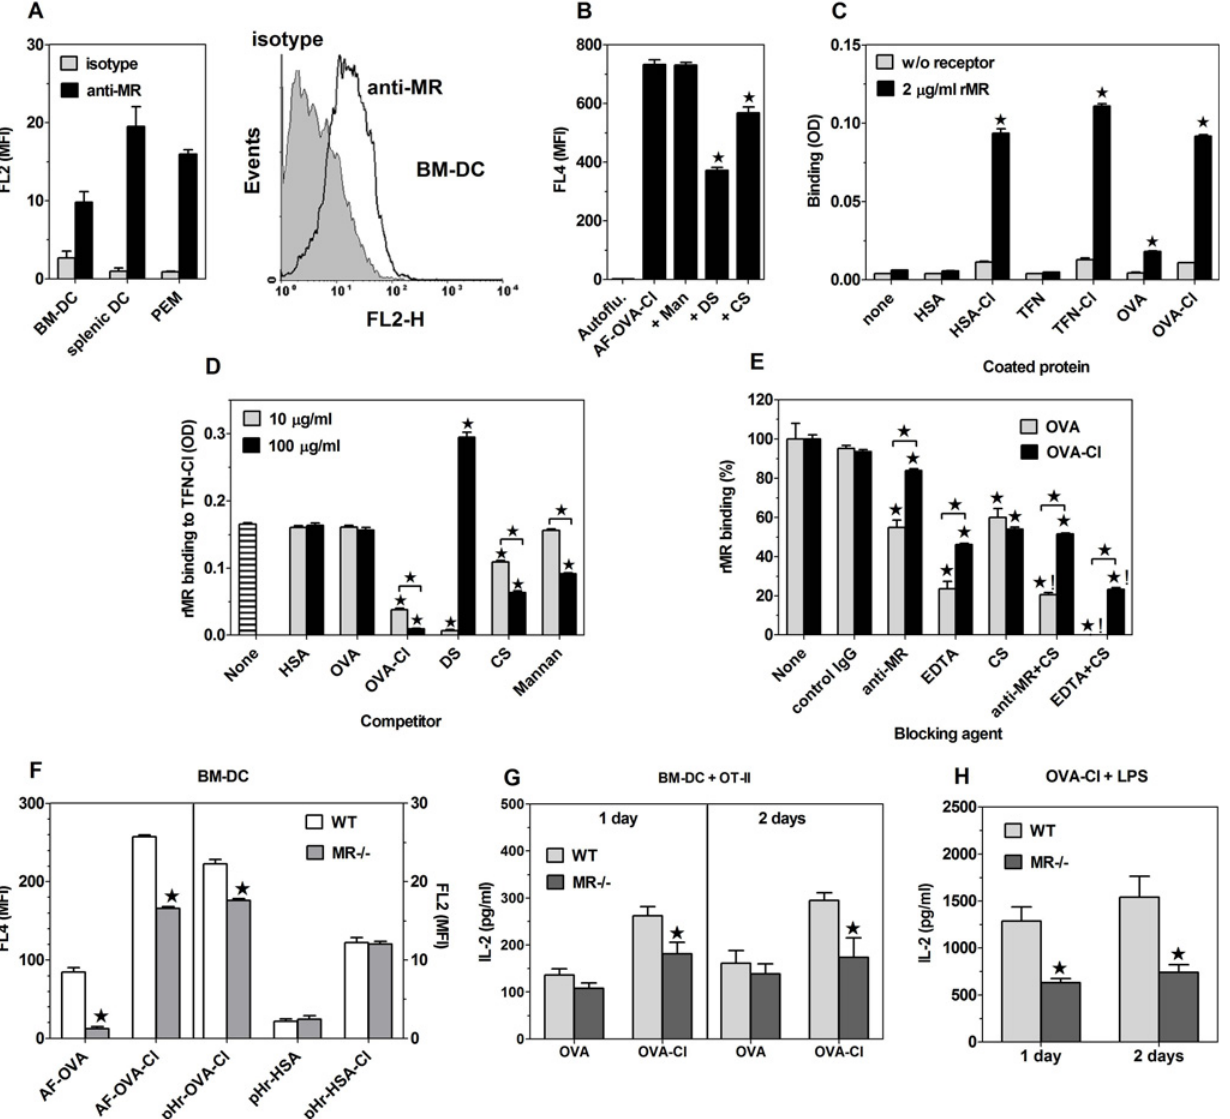
Fig 10. The role of MR as a receptor for HOCl-modified proteins. ( A ) Geometric mean fluorescence intensity of anti-MR mAb and isotype-matched control rat IgG2a binding to BM-DC, splenic DC and PEM. The graph on the right shows a representative histogram for BM-DC. ( B ) Effects of mannan (Man), DS and CS on AF-OVA-Cl uptake by J774 cells. ( C ) Binding of rMR to plate-adsorbed proteins. ( D ) Effects of 10 or 100 μ g/ml of indicated, soluble ligands on rMR binding to plate-adsorbed TFN-Cl. ( E ) Effects of agents selectively blocking C-type lectin domains (EDTA, anti-MR mAb) or the cysteine-rich domain (CS) on rMR binding to plate-adsorbed OVA or OVA-Cl. ( F ) Uptake of indicated, fluorescently-labelled ligands by WT and MR-/- BM-DC. ( G , H ) IL-2 production in the co-culture of CD4 + OT-II lymphocytes with WT or MR-/- BM-DC pulsed for 3.5 h with 20 μ g/ml OVA, 7 μ g/ml OVA-Cl (G) or OVA-Cl + 200 ng/ ml LPS (H). The results shown are averages +SEM from 4 independent experiments (A, F-H) or mean values +SEM obtained in single experiments, repeated 2 – 3 times with similar results (B-E). The data were analysed by the Student ’ s t-test (C, F-H) or by ANOVA, followed by the Tukey-Kramer post-test (B, D, E). * , p < 0.05;!, a statistically significant additive effect of two ligands; NS,